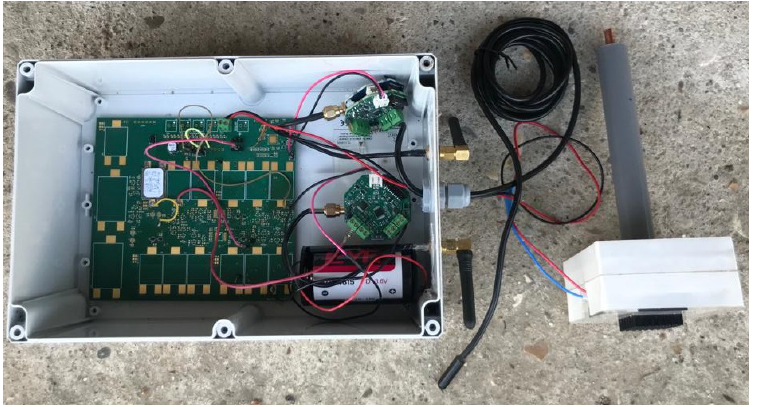
Figure 9. A finished unit with data logger assembled in IP66 ABS enclosure ready for deployment.